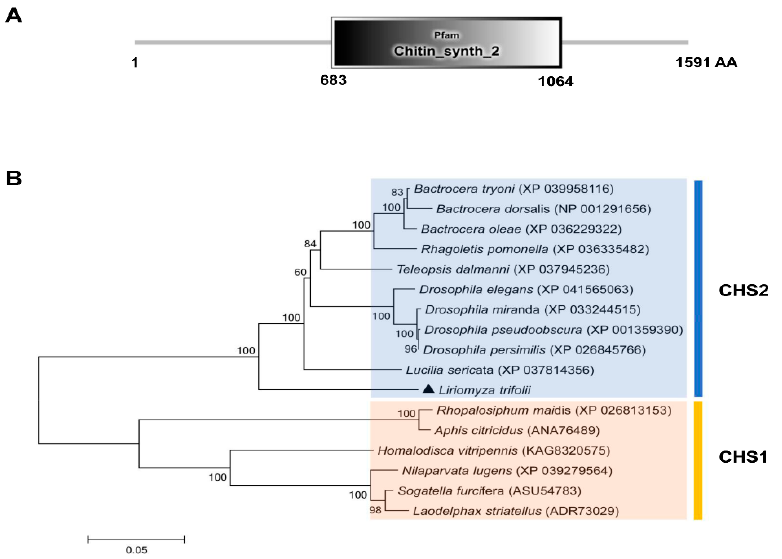
Figure 1. The domain organization of CHS2 ( A ) and the neighbor-joining phylogenetic tree of CHS2 ( B ). L. trifolii CHS2 is labeled with triangles. Numbers on the branches represent bootstrap values obtained from 1000 replicates (only bootstrap values >50 are shown).